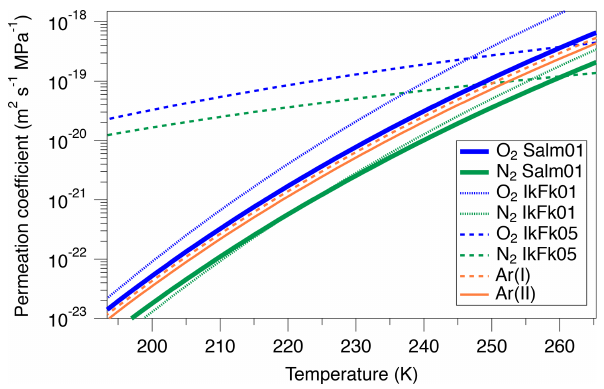
Figure 2. Permeation coefficients of O 2 , N 2 , Ar, and air, estimated by different authors. See text for